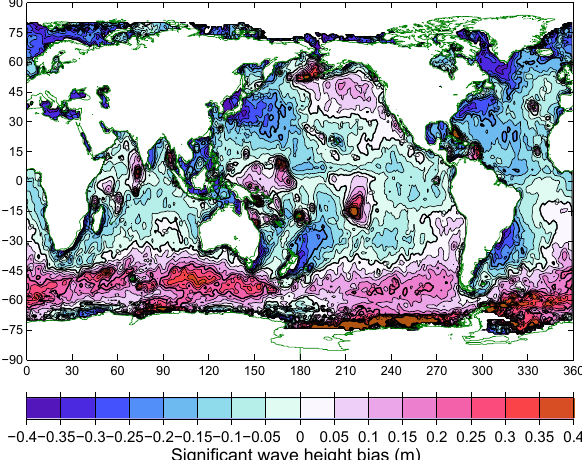
Figure 6. Bias in significant wave height from the hindcast com- pared with satellite altimeter measurements, over the period Au- gust 1991–December